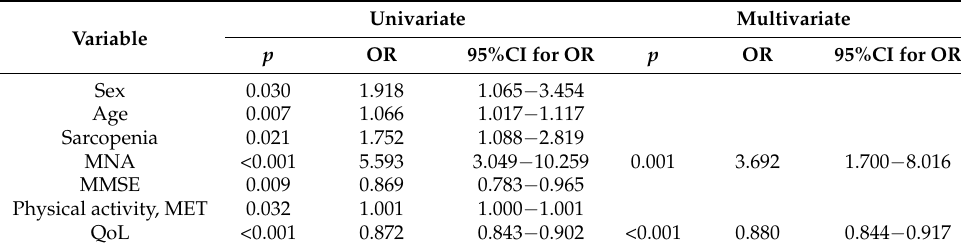
Table 3. Univariate and multivariate logistic regression analysis with depression as a dependent variable.